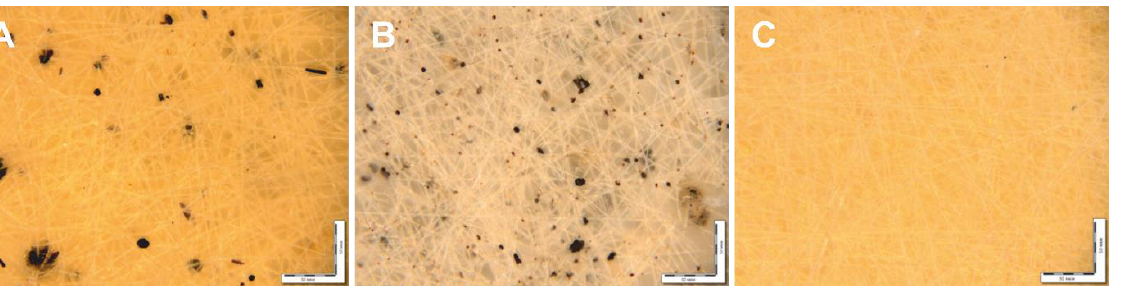
Figure 2. The micrographs of Hmi /PHB fibrous nanocomposites with different content of hemin: 1 wt.% ( A ), 3 wt.% ( B ), and 5 wt.% ( C ). 1 wt.% ( A ), 3 wt.% ( B ), and 5 wt.% ( C